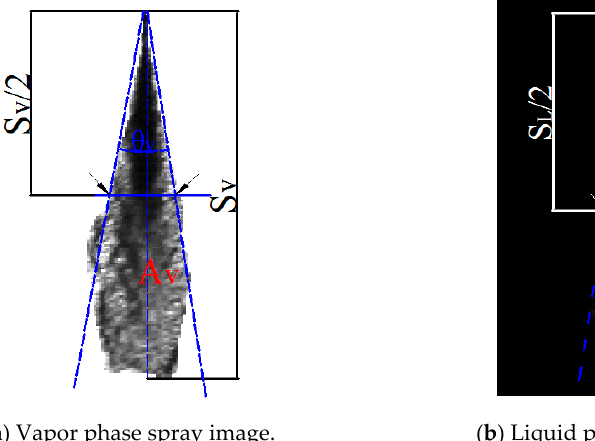
Figure 5. Definition of various spray parameters.